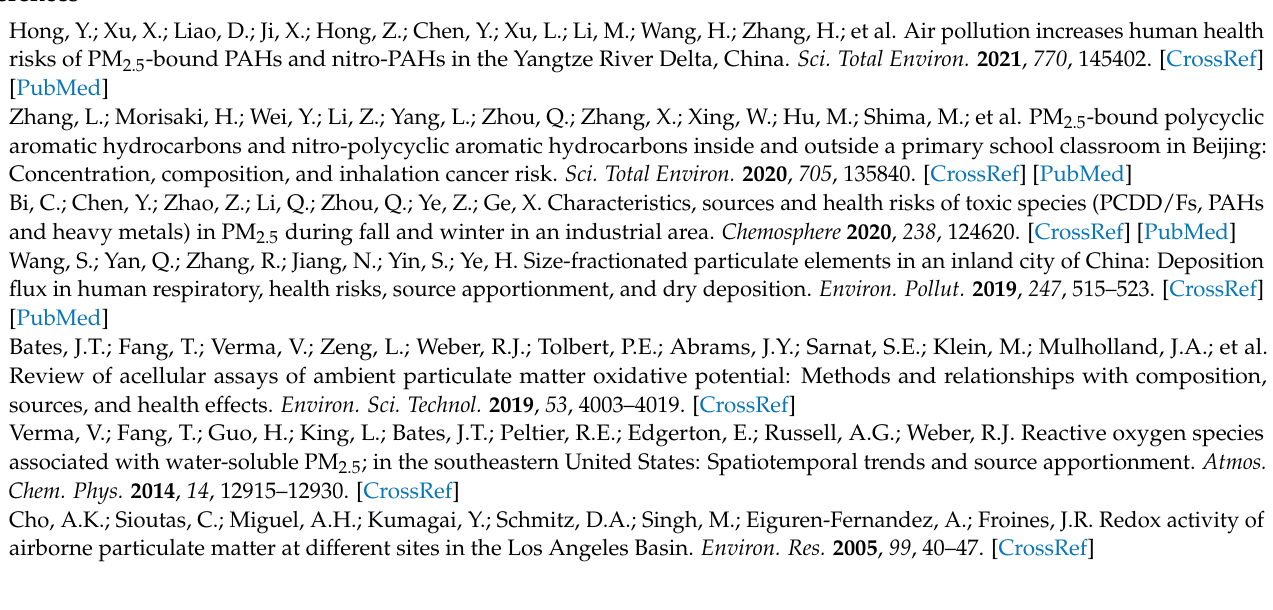
Figure S3: Summary of key diagnostic plots of the PMF results in spring: (a) Q/Qexp as a function of number of factors (b) the box and whiskers plot showing the distributions of scaled residuals for each m/z , (c) time series of the measured WSOA and the reconstructed WSOA.; Figure S4: Summary of key diagnostic plots of the PMF results in summer: (a) Q/Qexp as a function of number of factors (b) the box and whiskers plot showing the distributions of scaled residuals for each m/z , (c) time series of the measured WSOA and the reconstructed WSOA.; Figure S5: Positive matrix factorization of AMS data of WSOM in spring for (a) three-solution, (b) four-solution and (c) five-solution.; Figure S6: Positive matrix factorization of AMS data of WSOM in summer for (a) three-solution, (b) four-solution and (c) five-solution.; Figure S7: Correlations between PMF-predicted PM2.5 mass concentration and measured PM2.5 mass concentrations for three factors.; Figure S8: Time series of gaseous SO2 and NO2 during sampling period.; Figure S9: (a) High resolution mass spectra and time series of WSOA components of 3-factor solution from PMF, (b) Triangle plots (f44 vs. f43) of WSOA and (c) contributions of resolved factors to WSOA in spring.; Figure S10: Correlation of resolved factors from PMF with special tracers in spring.; Figure S11: Average mass contributions of identified sources to DTTv of WSOM during (a) spring and (b) summer.; Figure S12: verage mass contributions of identified sources to PM2.5 during (a) spring and (b)